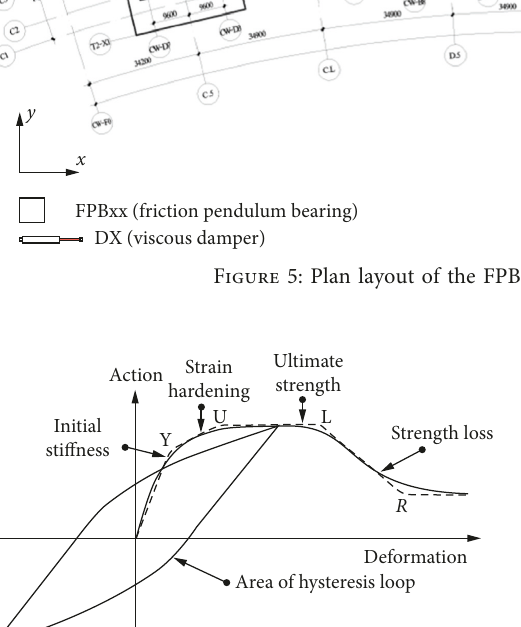
Figure 8: Degradation coefficients of concrete.